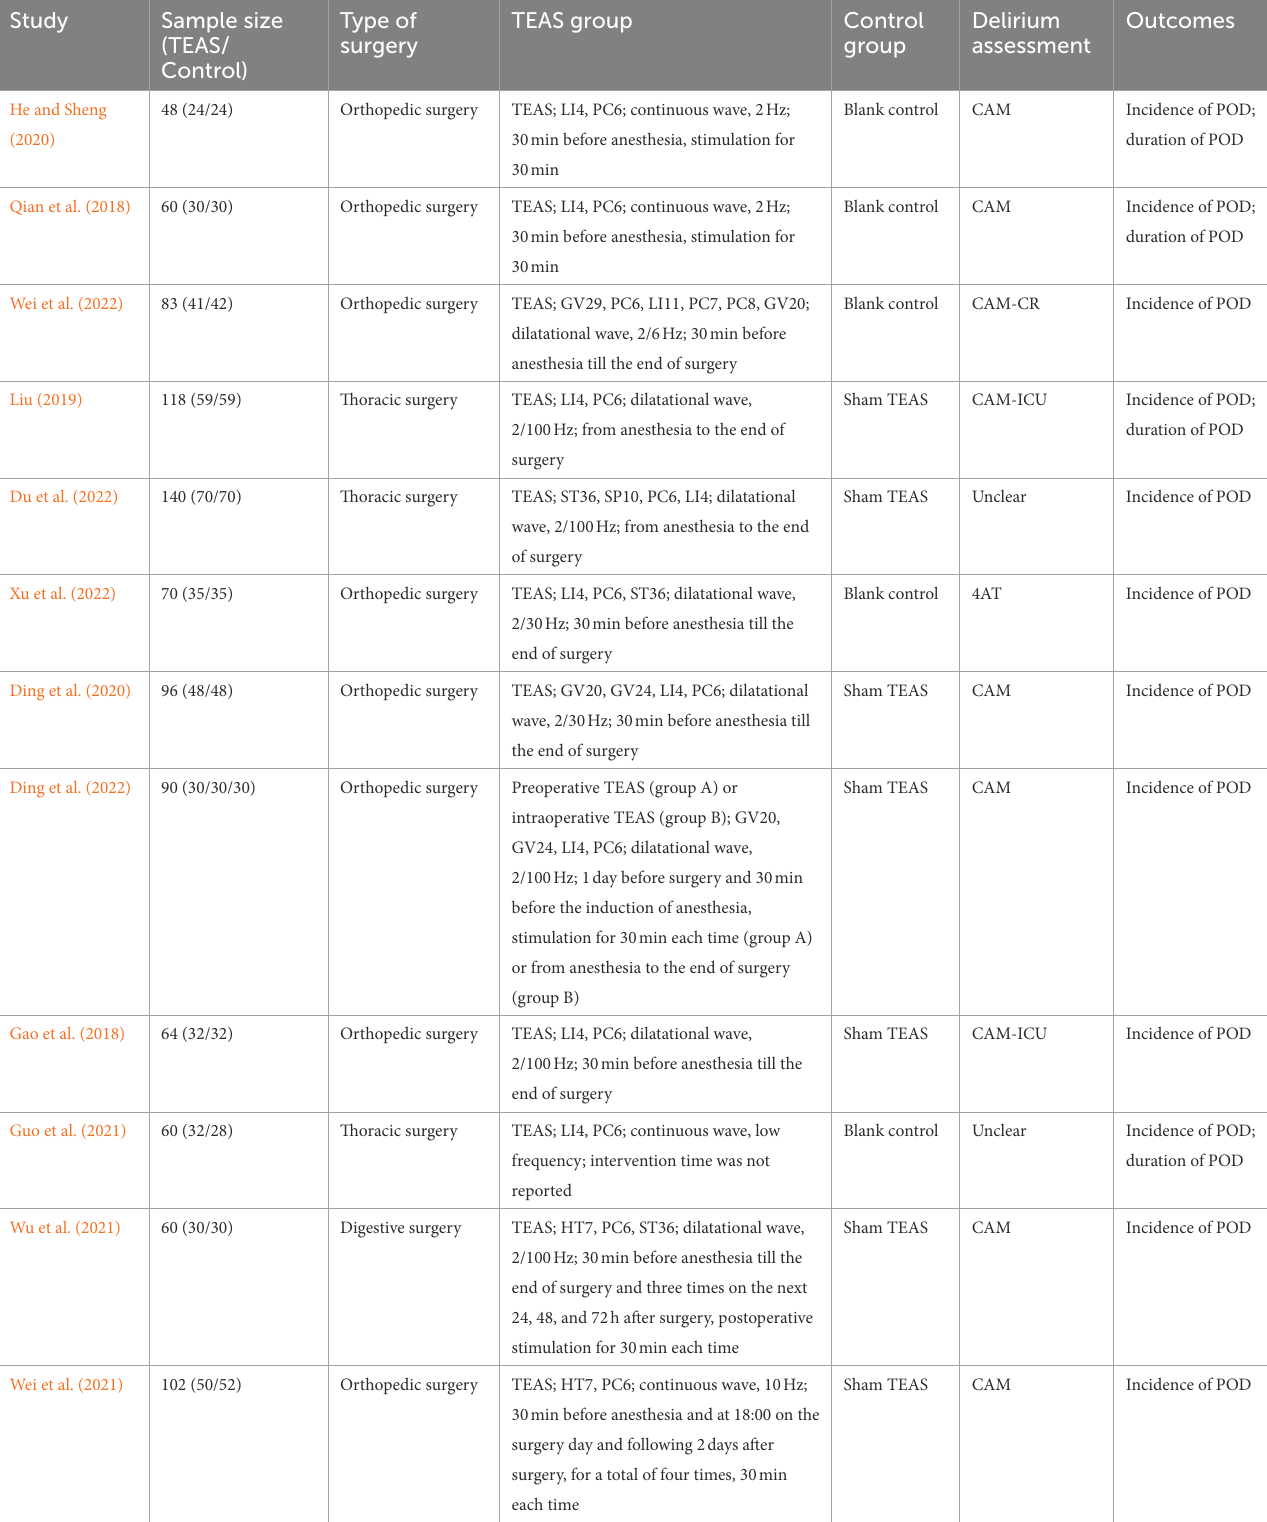
TABLE 1 Characteristics of the included studies.